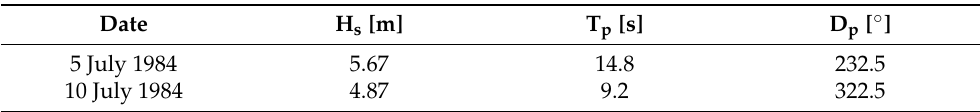
Figure 2. ( A ) Wave conditions at deep water (5.67 m) from 28 June to 11 July 1984 and ( B ) wave conditions at deep water (4.87 m) from 9 July to 20 July 1984. Hs: wave height, Tp: peak period, Dp: peak direction. The point is − 31, − 73 (https://oleaje.uv.cl/descargas.html, access date: 20 October 2021). The data come from the Universidad Valdivia wave atlas database, which is a hindcasting (reconstruction) of wave conditions. Table 2. Wave parameters in deep water for SWAN model propagation. Hs: wave height, Tp: peak period, Dp: peak